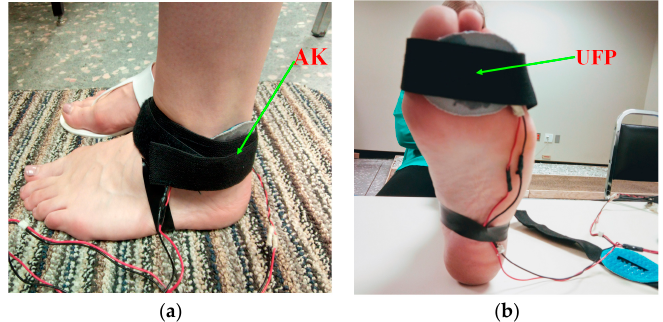
Figure 2. The device is worn on the left foot, and a strap holding the haptuator is located on the two lower extremities where the fast mechanoreceptors (FA-I and FA-II) are more represented in order